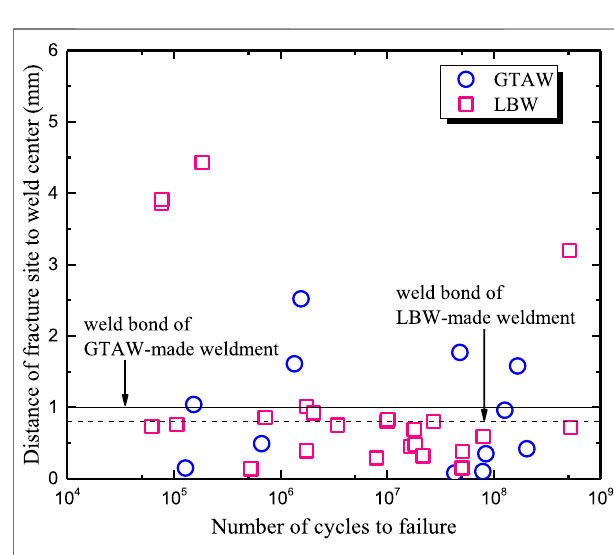
FIGURE 10 | Relationship fracture site and the number of cycles to